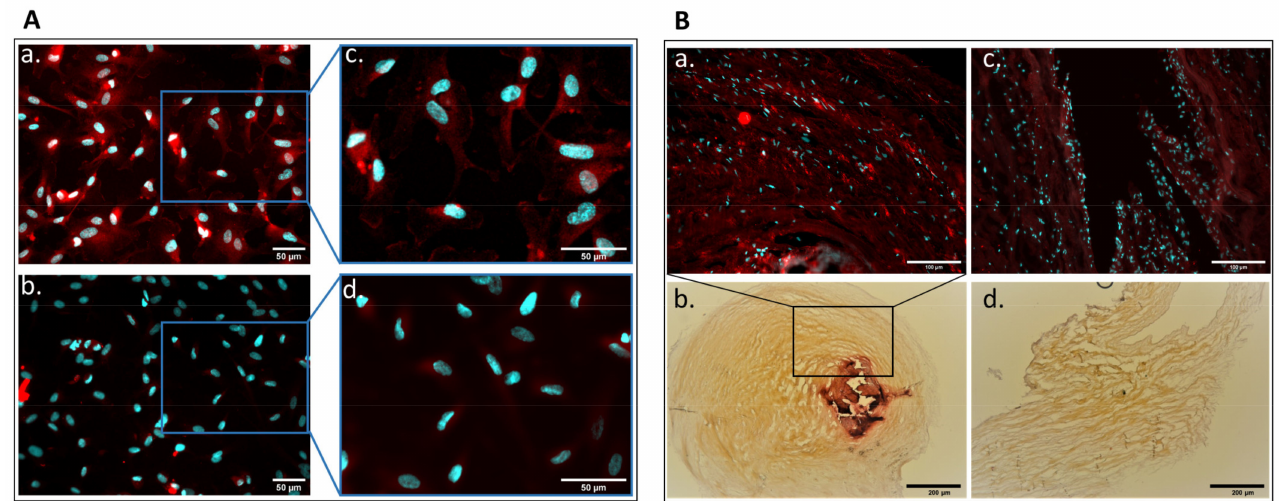
Figure 1. Parathyroid hormone receptor (PTHR) is present on cultured valvular endothelial cells and human heart valve. The expression of PTHR was evaluated by immunofluorescence using a specific primary PTHR antibody and Alexa-coupled secondary antibody (red) on cultured VEC ( A ( a ) and inset in A ( c )) a human valve section ( B ) with calcium deposits ( B ( a )) or without calcium deposits ( B ( c )). The negative control, Alexa-coupled secondary antibody staining, is present in Ab and inset in Ad. Nuclei were stained with DAPI (blue staining). The calcific zones of the valve section are marked by Alizarin Red staining ( B ( b , d